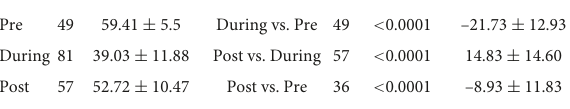
TABLE 4 Global longitudinal strain during episode and following